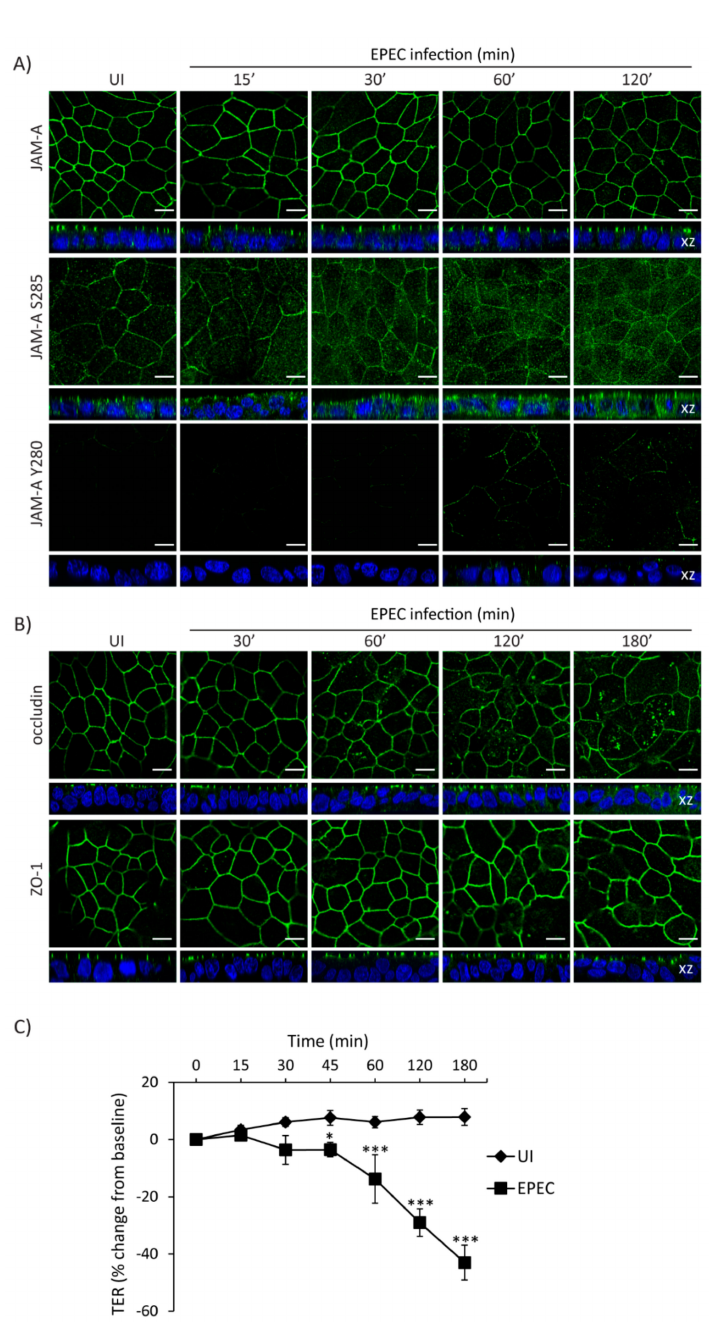
Figure 5. Temporal redistribution of TJ proteins and barrier dysfunction caused by EPEC. ( A–C ) SKCO-15 cells were plated on Transwells and infected or not (UI) with EPEC. Total JAM-A, JAM-A S285, JAM-A Y280, occludin, and ZO-1 localization and TER were determined. ( A ) EPEC does not alter the distribution of total JAM-A. In contrast, JAM-A S285 is displaced from the cell–cell contacts to the cytoplasm at 30 min post-infection. Tyrosine phosphorylation of JAM-A Y280 is apparent at 60–120 min post-infection. Scale bars, 10 µ m. ( B ) EPEC induces the endocytosis of occludin and ZO-1 at 1 and 2 h post-infection, respectively. Scale bars, 10 µ m. ( C ) TER drops significantly as early as 45 min post-infection and progressively decreases over time as more TJ proteins are displaced. TER reported as percent change from baseline. * p < 0.01, *** p <